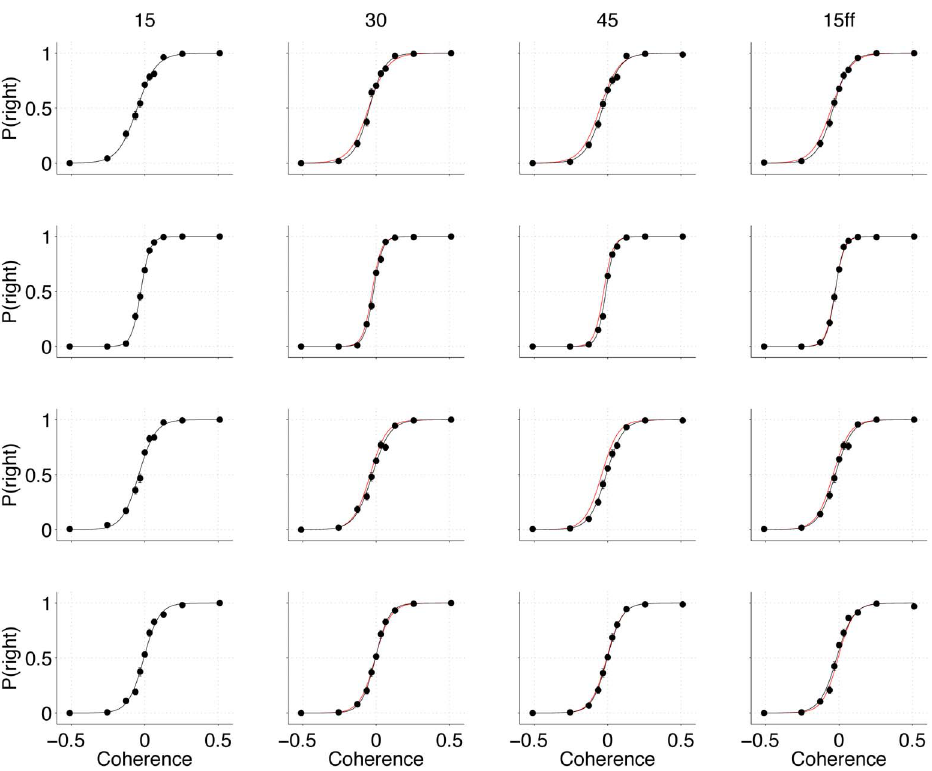
Figure 6. Initial choice function. Graphs show the probability of a rightward choice as a function of motion strength (sign of coherence reflects dot motion direction: left or right) for each subject and condition. Curves are logistic fits. For comparison the red curve for each subject is the logistic fit to their 15 u condition. Error bars are s.e.